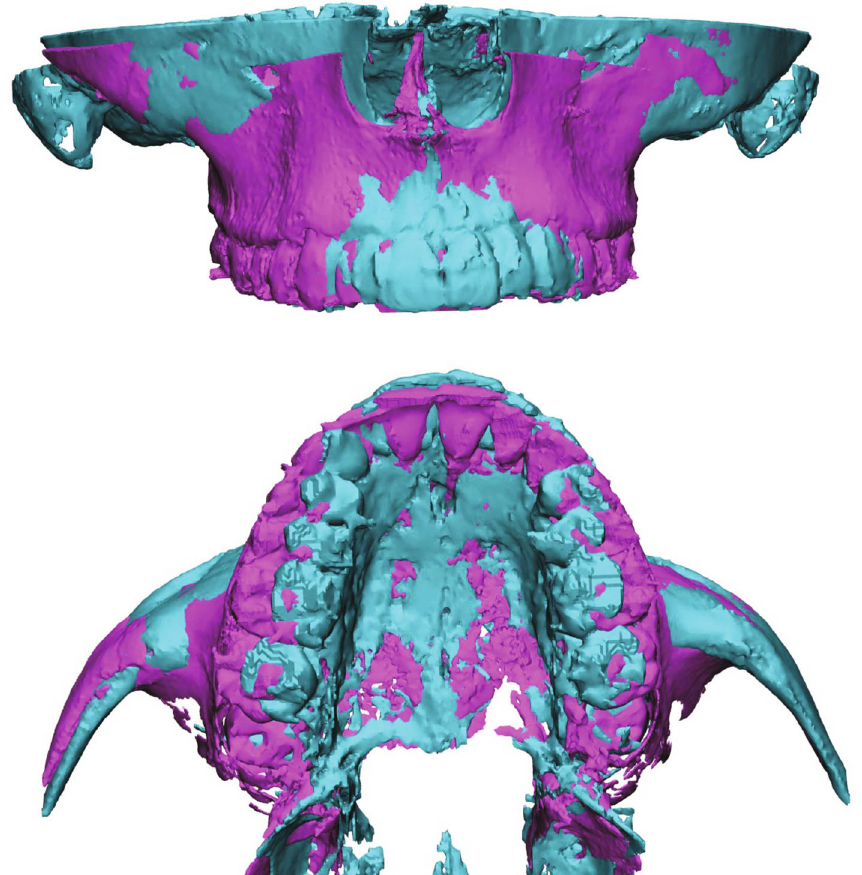
Figure 10: Superimposition of CBTC, light blue pre- and violet